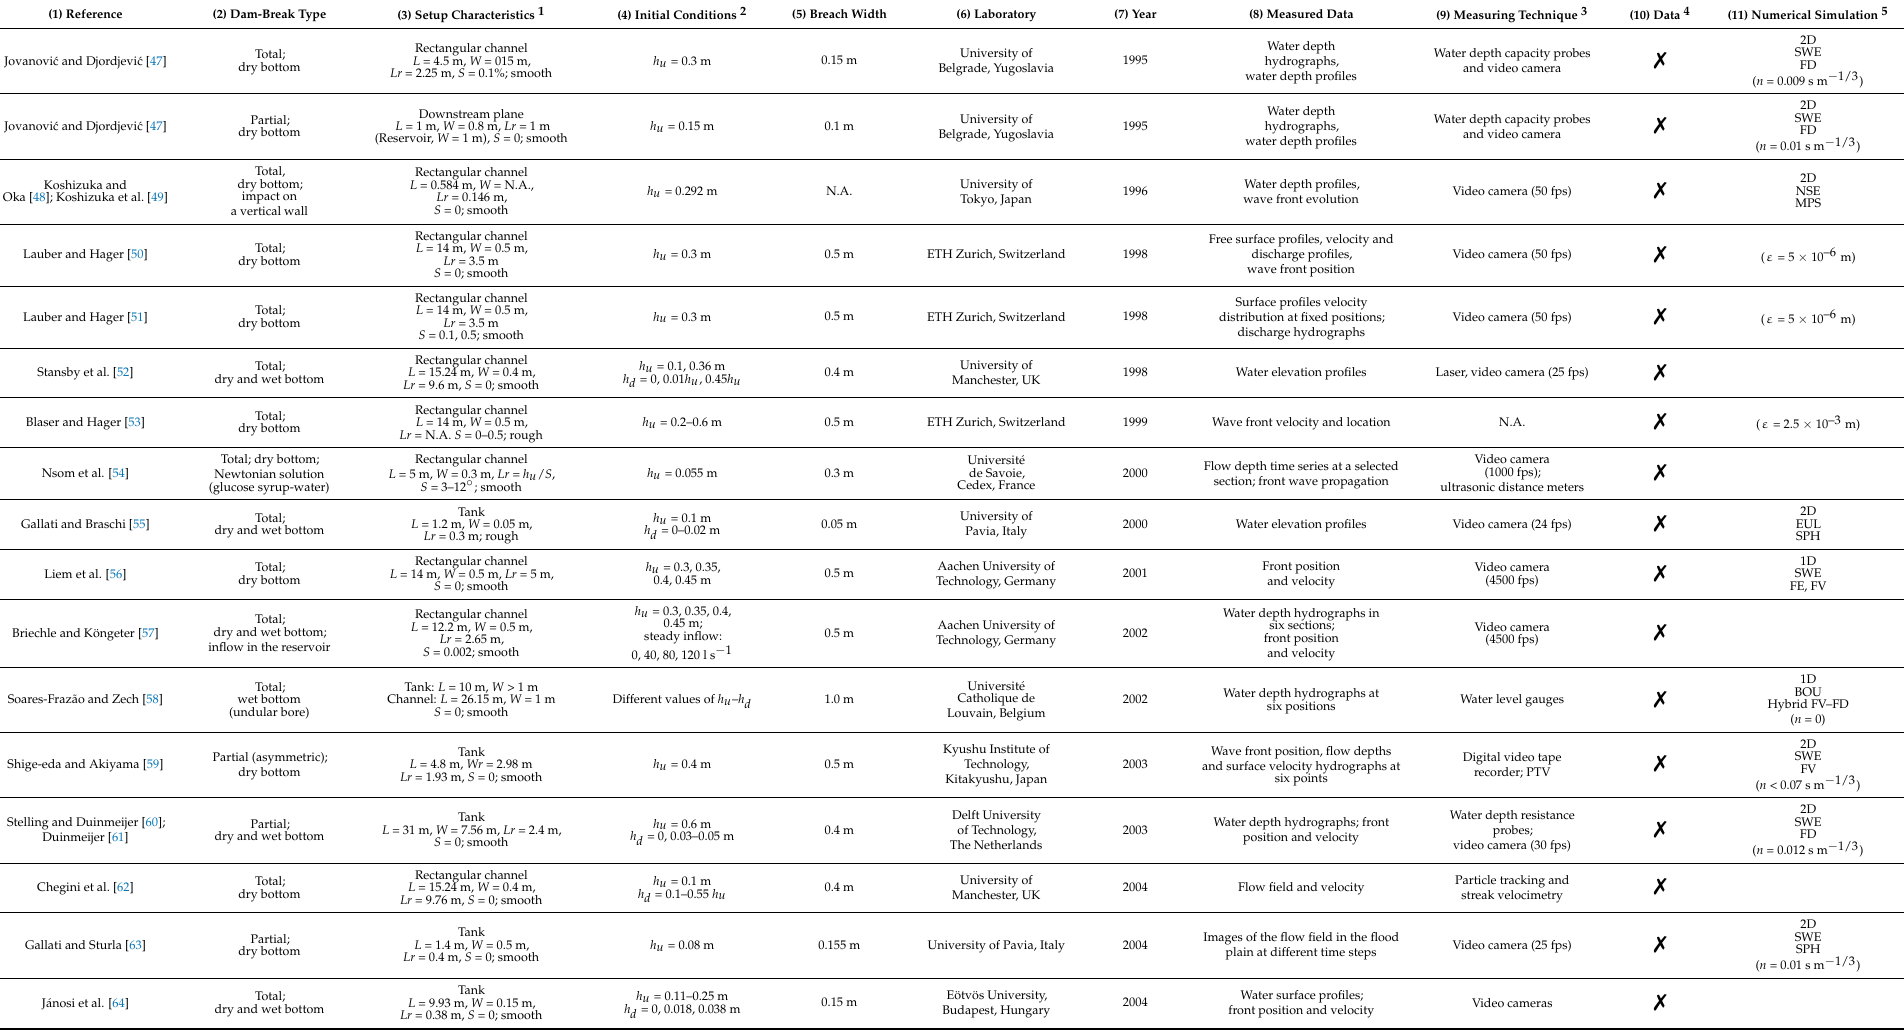
Table 1. Basic experimental investigations of fundamental dam-break wave physical characteristics.